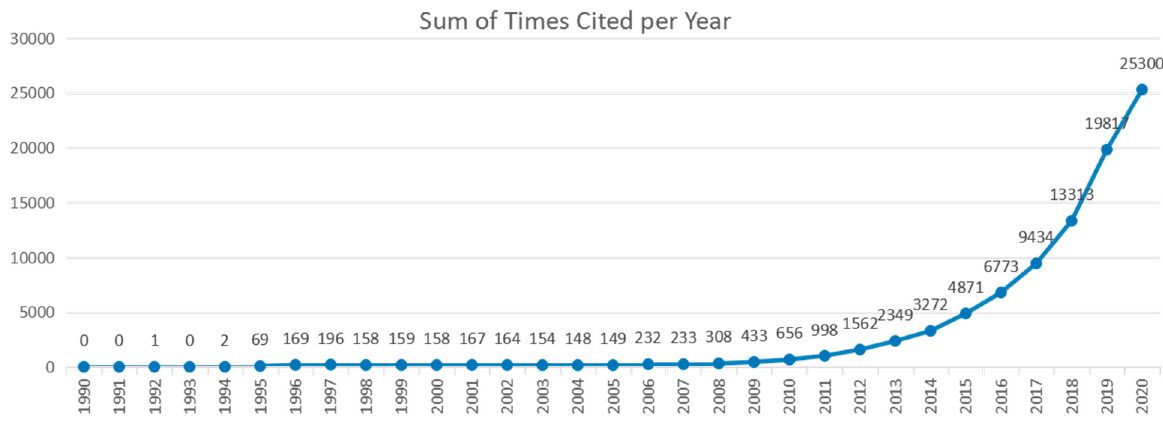
Figure 3. Line chart of citation trend from 1990 to 2020 (number of cited articles per year).